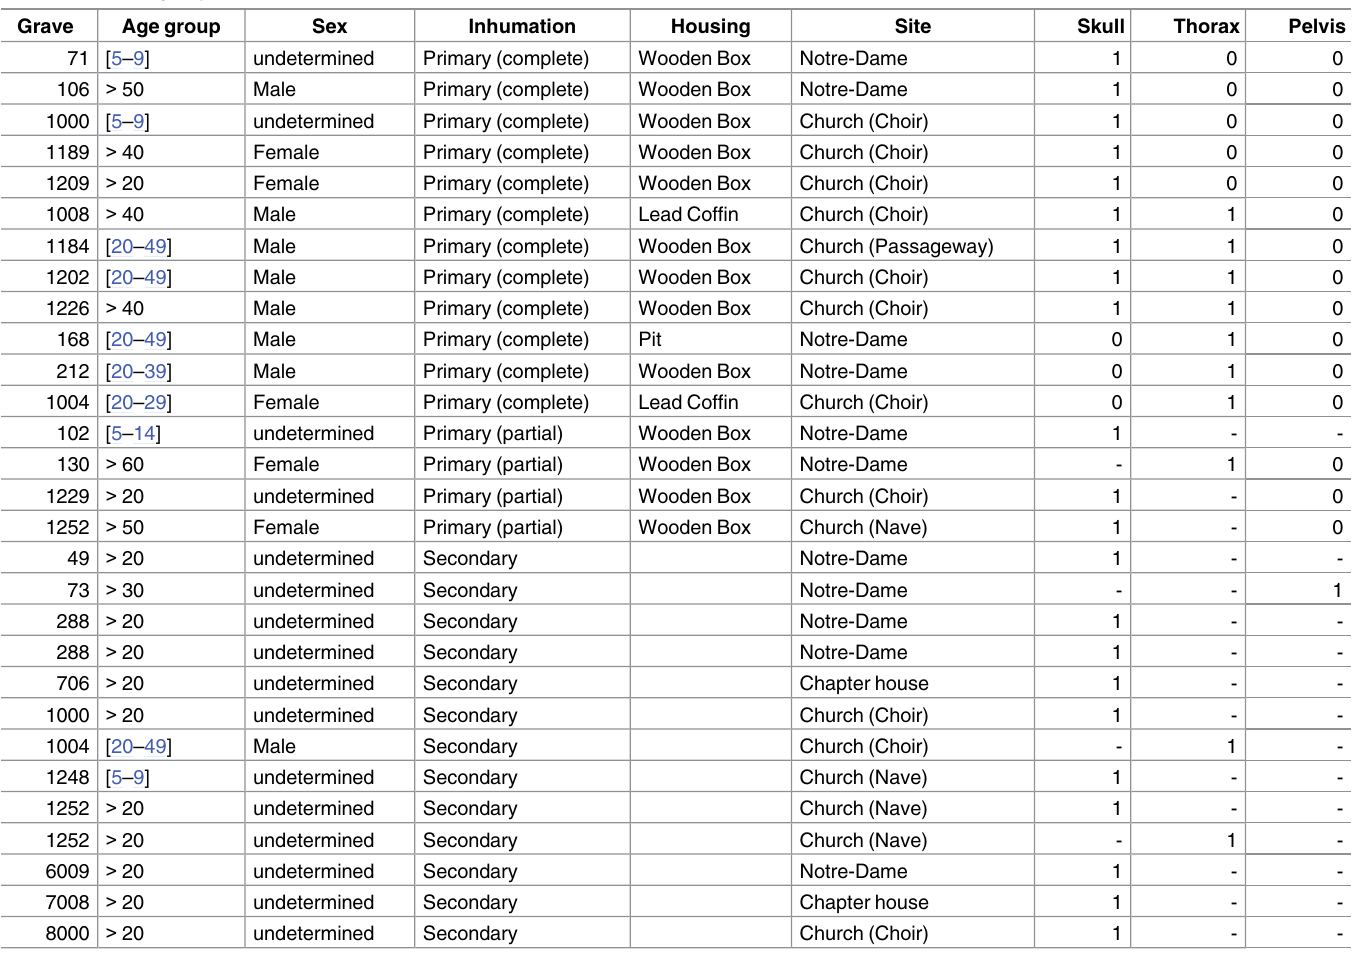
Table 1. Inventory of post-mortem cuts and / or saw marks on